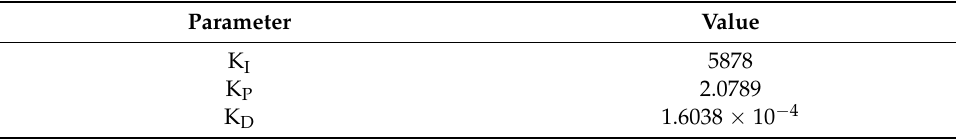
Table 4. PID Controller Parameters.